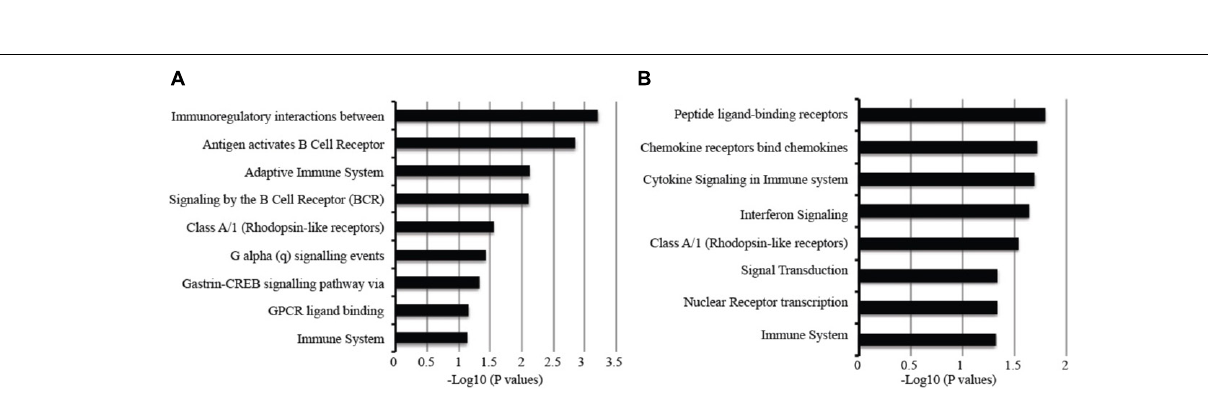
Frontiers in Genetics |